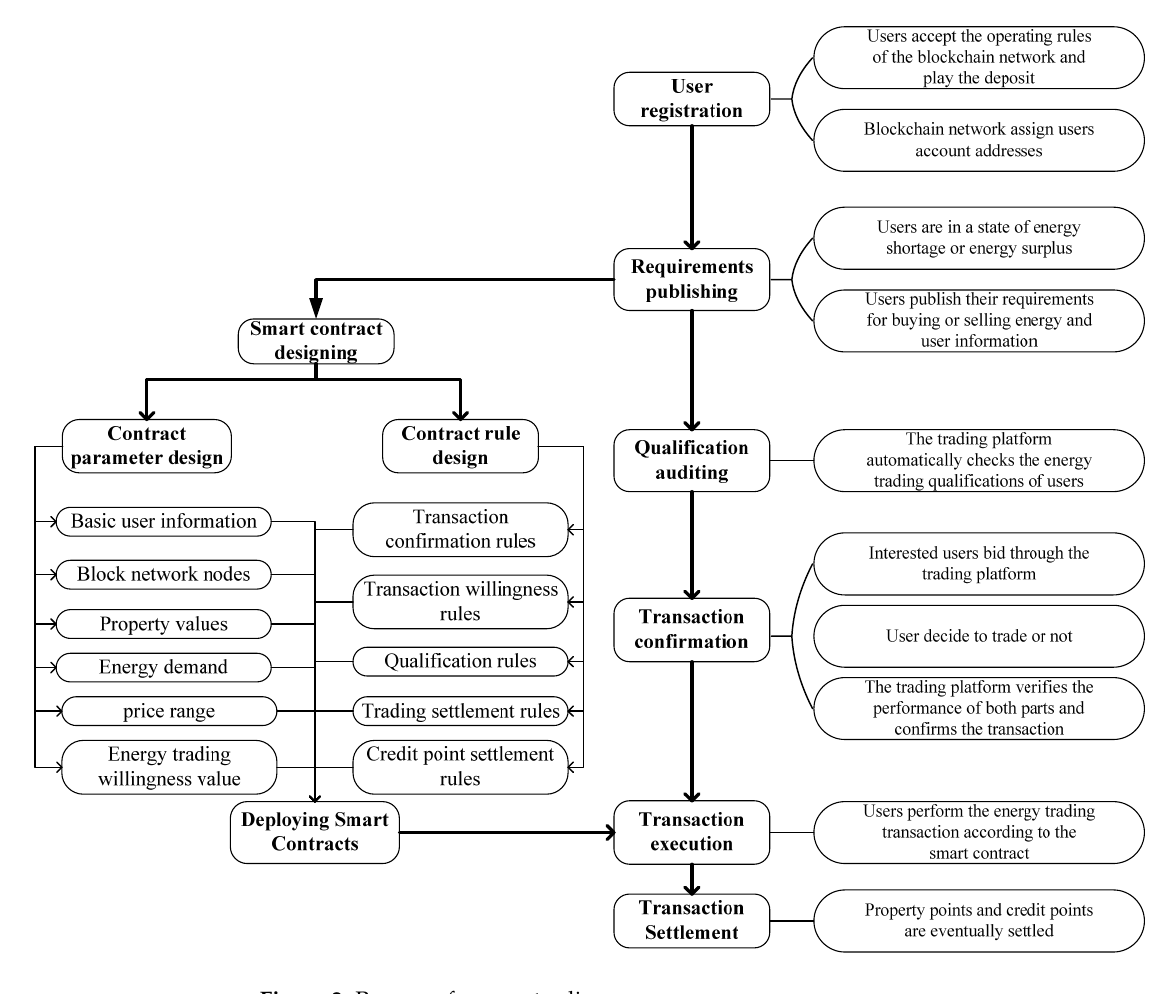
Figure 2. Process of energy trading.